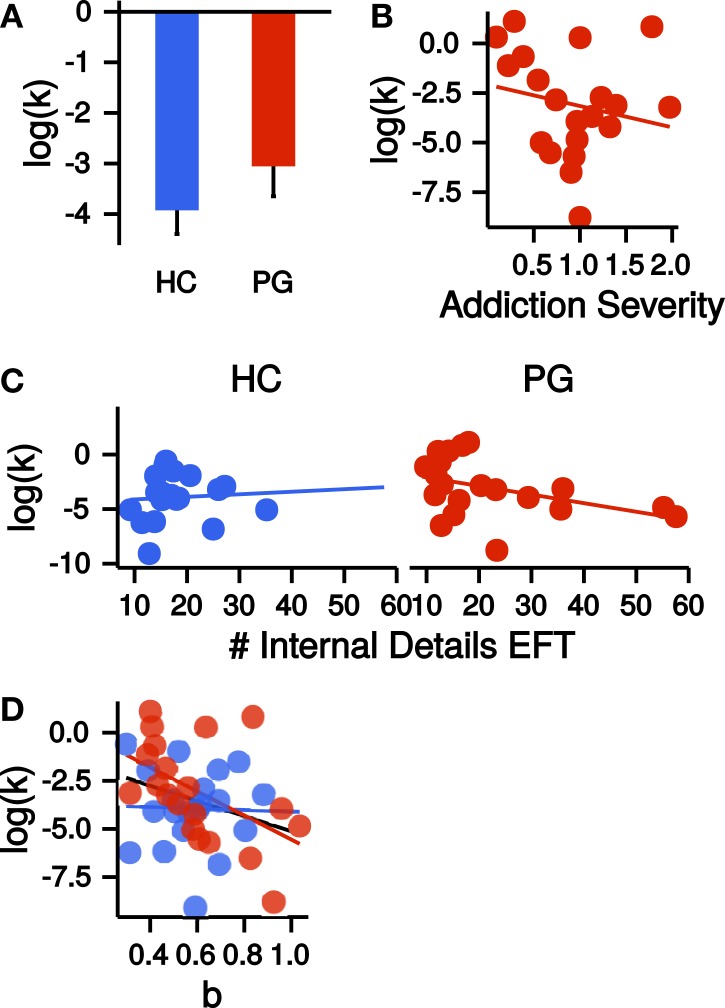
(A) Group difference in the log-transformed k parameter of the temporal discounting task. HC, healthy control participants, PG, pathological gamblers. Error bars are indicating SEM. (B) Correlation of log-transformed temporal discounting k parameters with addiction severity scores in PGs (r = −0.20, p = 0.40). (C) Correlation of the number of internal details in the episodic future thinking (EFT) condition with log-transformed temporal discounting parameters k separate for HCs (r = 0.07, p = 0.77) and PGs (r = −0.41, p = 0.07). (D) Correlation of exponent b of the power law time perception (corrected by circle-size estimation) with log-transformed temporal discounting parameters k across both groups (black, r = −0.30, p = 0.06) and separate for HCs (blue, r = −0.03, p = 0.90) and PGs (red, r = −0.50, p = 0.03).